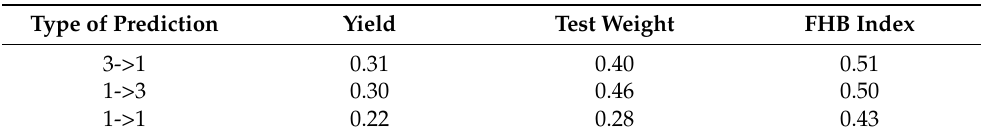
Table 6. Average accuracy of different types of predictions for yield and test weight using data from the 5-state trials and for FHB Index using data from the P+NUWWSN trials. A 3->1 prediction used BLUES derived from data from three programs to predict the performance of the same lines in the other program. A 1->3 prediction used BLUES derived from one program to predict the BLUES of the same lines over the other three programs. A 1->1 prediction used BLUES from one program to predict the BLUES of the same from the other